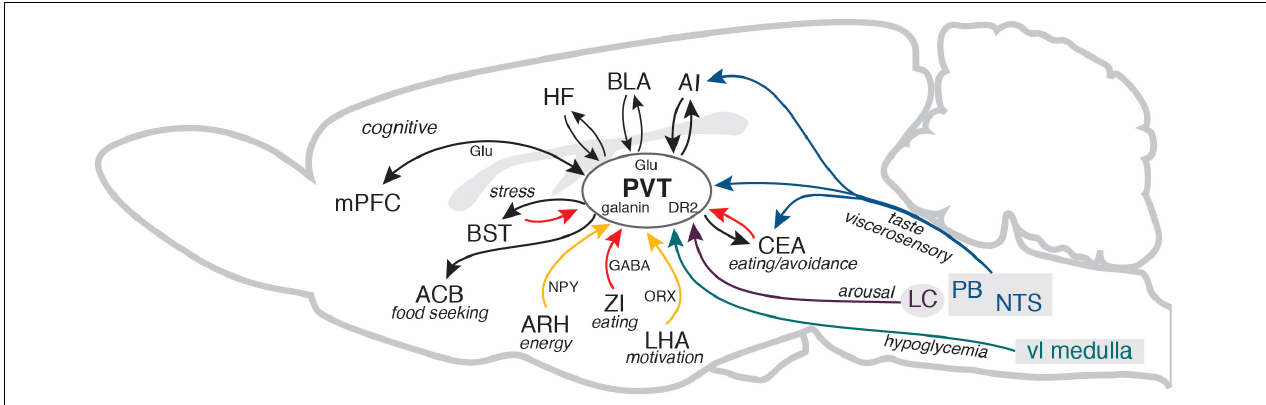
FIGURE 1 | The diagram illustrates several key PVT connections discussed in the manuscript in the context of adaptive control of feeding behavior. For clarity, some connections between the areas, other brains areas that participate in the circuitry, and different PVT neurons that contain specific peptides or receptors are not shown. Cortical and thalamic glutamatergic pathways (Glu) are shown in black and GABA pathways from the ZI, CEA, and BST are shown in red. AI, agranular insular cortex; ACB, nucleus accumbens; ARH, arcuate nucleus of the hypothalamus; BLA, basolateral area of the amygdala; BST, bed nuclei of the stria terminalis; CEA, central nucleus of the amygdala; DR2, dopamine receptor 2; HF, hippocampal formation (ventral CA1 and subiculum); LC, locus coeruleus; LHA, lateral hypothalamic area; mPFC, medial prefrontal cortex; NPY, neuropeptide Y; NTS, nucleus of the solitary tract; ORX, orexin/hypocretin; PB, parabrachial nucleus;